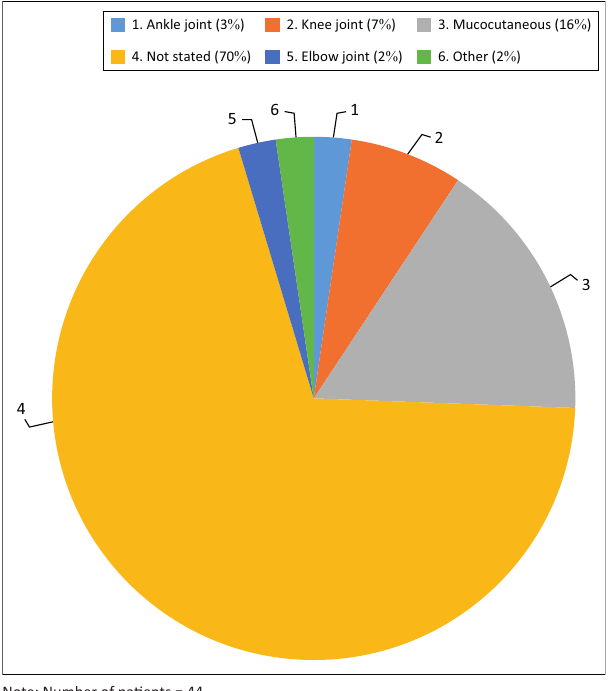
FIGURE 2: Bleeding sites in patients with haemophilia at Dr George Mukhari Academic Hospital. TABLE 3: The profile of inhibitor development. Inhibitor description